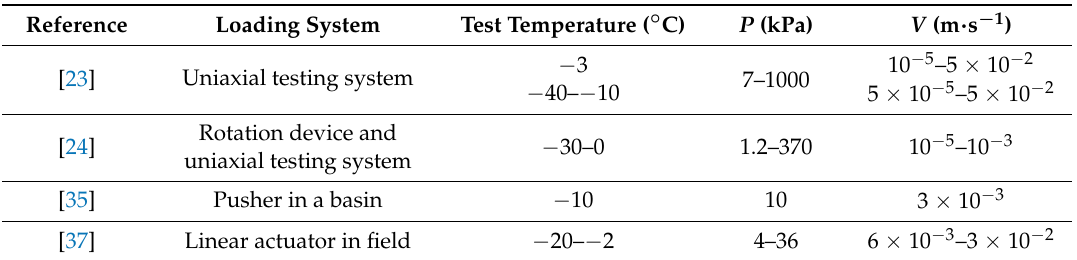
Table 1. Information on stick-slip from previous